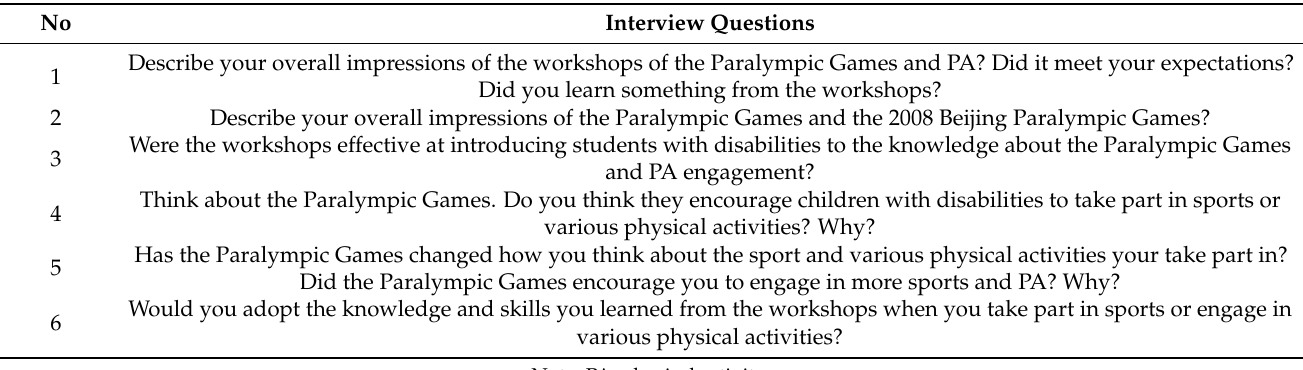
Table 2. Post-implementation Interview